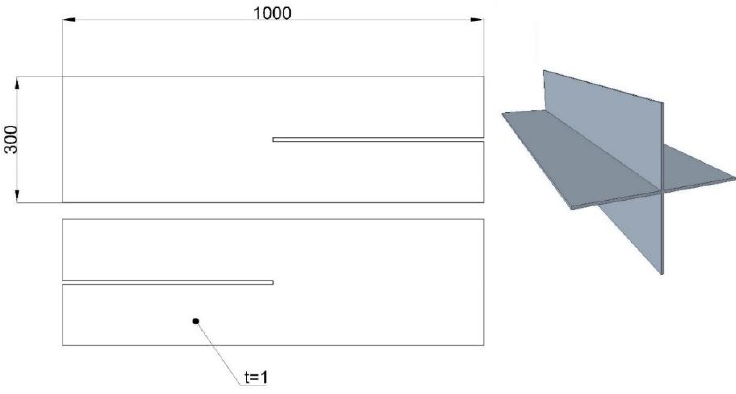
Figure 1. Partition made of two sheets, welded in the shape of a cross. Table 1. Increase in the collection area.